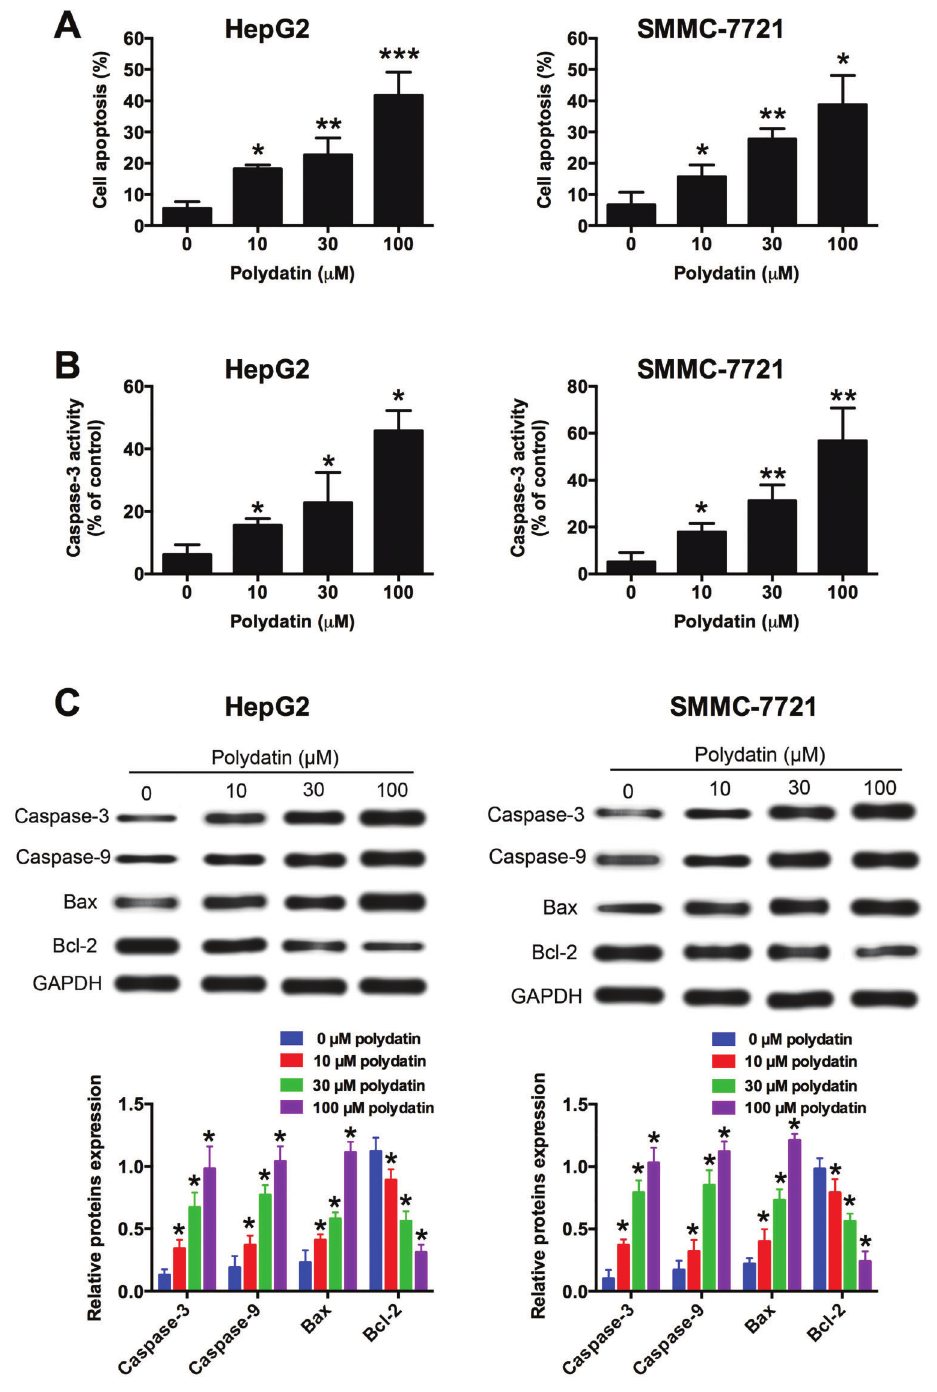
Figure 2. Effects of polydatin on cell apoptosis in liver cancer cell lines treated with different concentrations of polydatin for 48 h ( A ), determined by fl ow cytometry assay; B , effect of the treatment on caspase-3 activity measured by caspase-3 activity kit; C , protein expression levels of caspase-3, caspase-9, Bax, and Bcl-2 measured by western blotting assay. All experiments were repeated 3 times. Data are reported as means ± SD. *P o 0.05, **P o 0.01, and ***P o 0.001 compared to control group (one-way